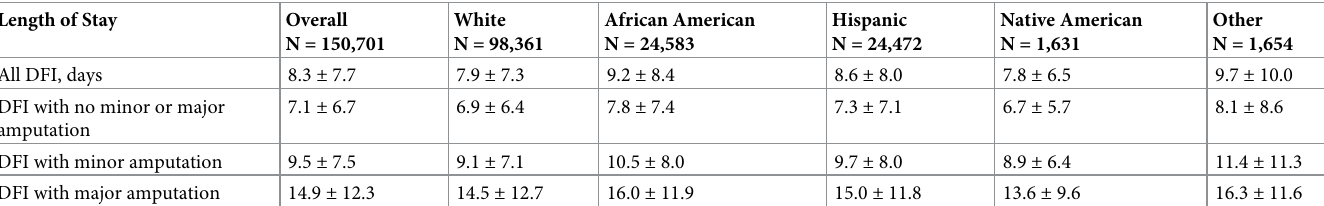
Table 3. Hospital length of stay for patients with diabetic foot